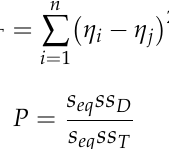
Table 6. Response of variable parameters of